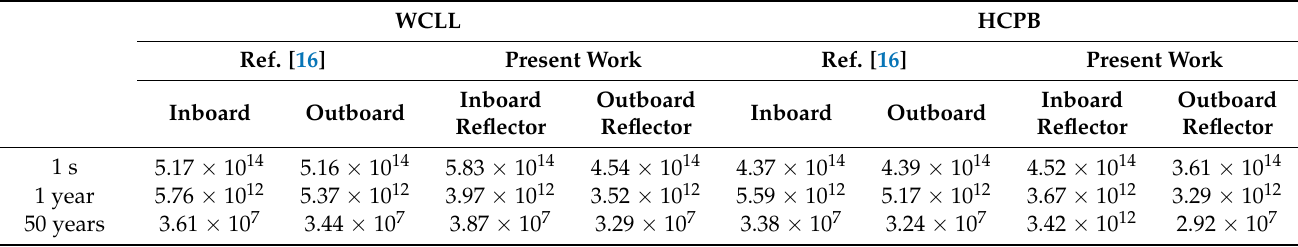
Figure 11. Comparison of total activities (in liner and reflector plates containing 3 mm of tungsten layer (present work)) and the first layer of divertor in [43]. Table 3. Comparison of specific activity with Ref. [16]